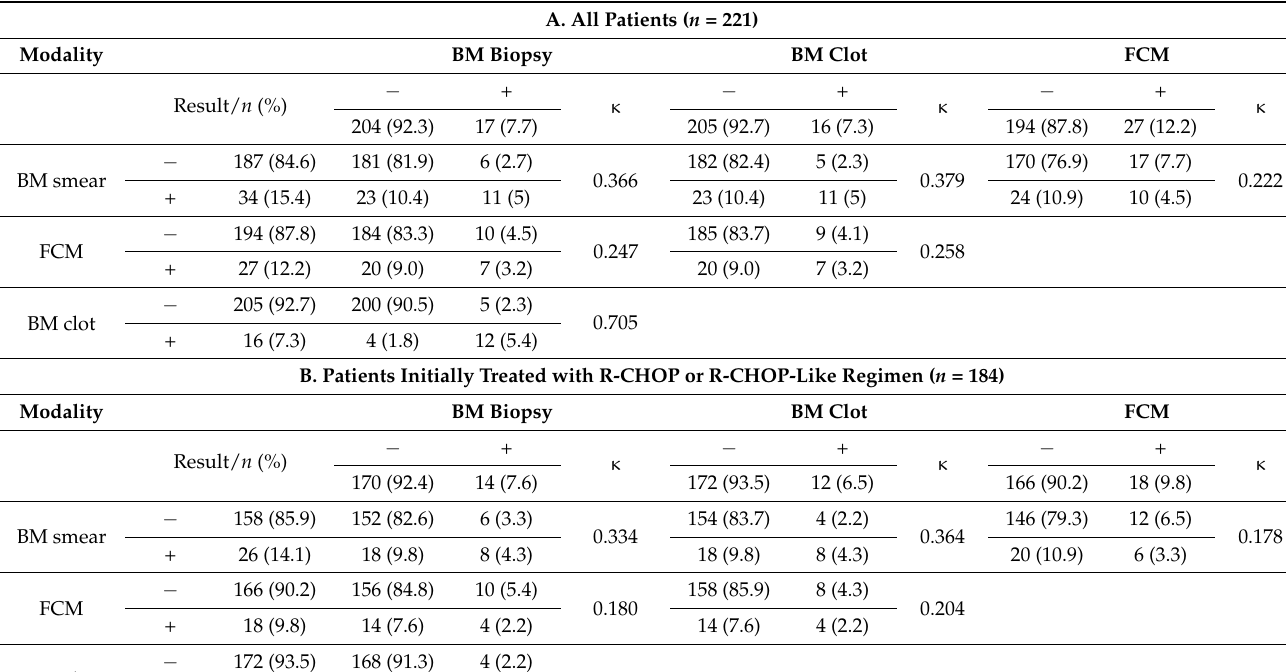
Table 2. Detection rates of bone marrow invasion of lymphoma cells by different modalities and the interexamination